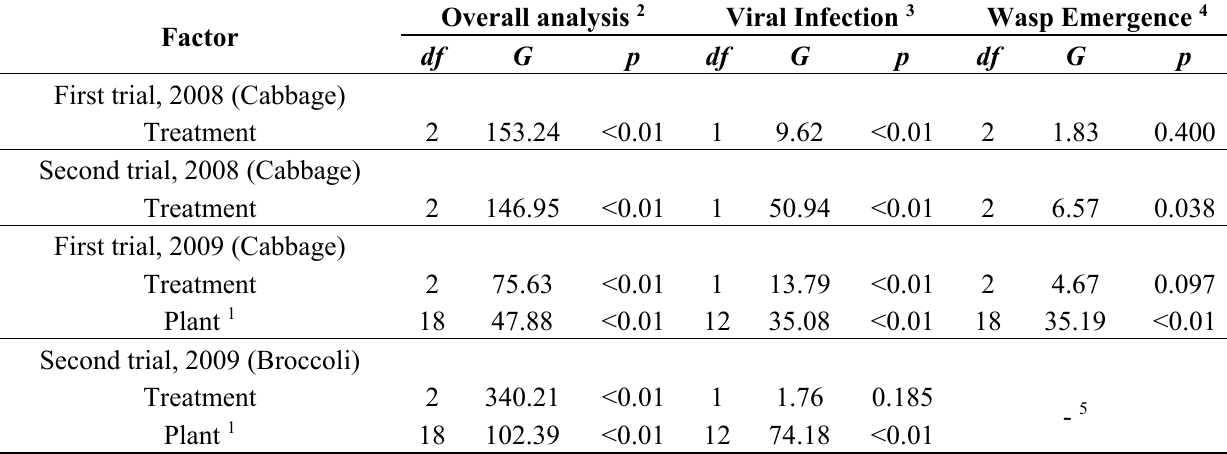
Table 2. Cox’s proportional hazard analysis (CPHA) of larvae collected from fields at four days post-application of virus